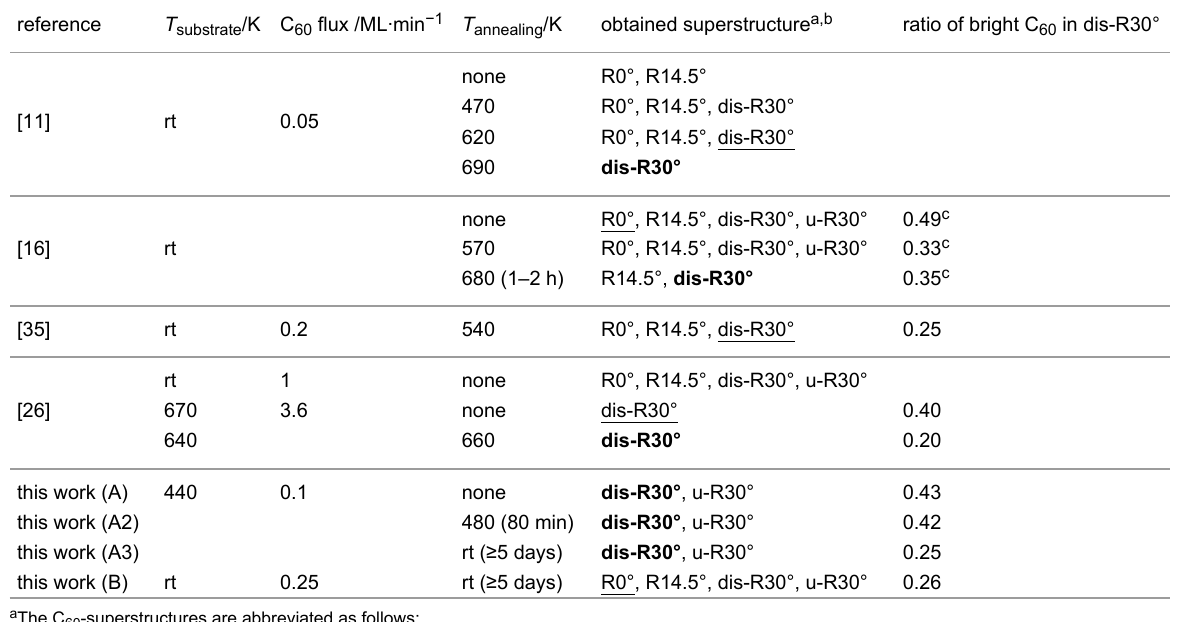
Table 1: Comparison of key preparation parameter and resulting C 60 -superstructures.